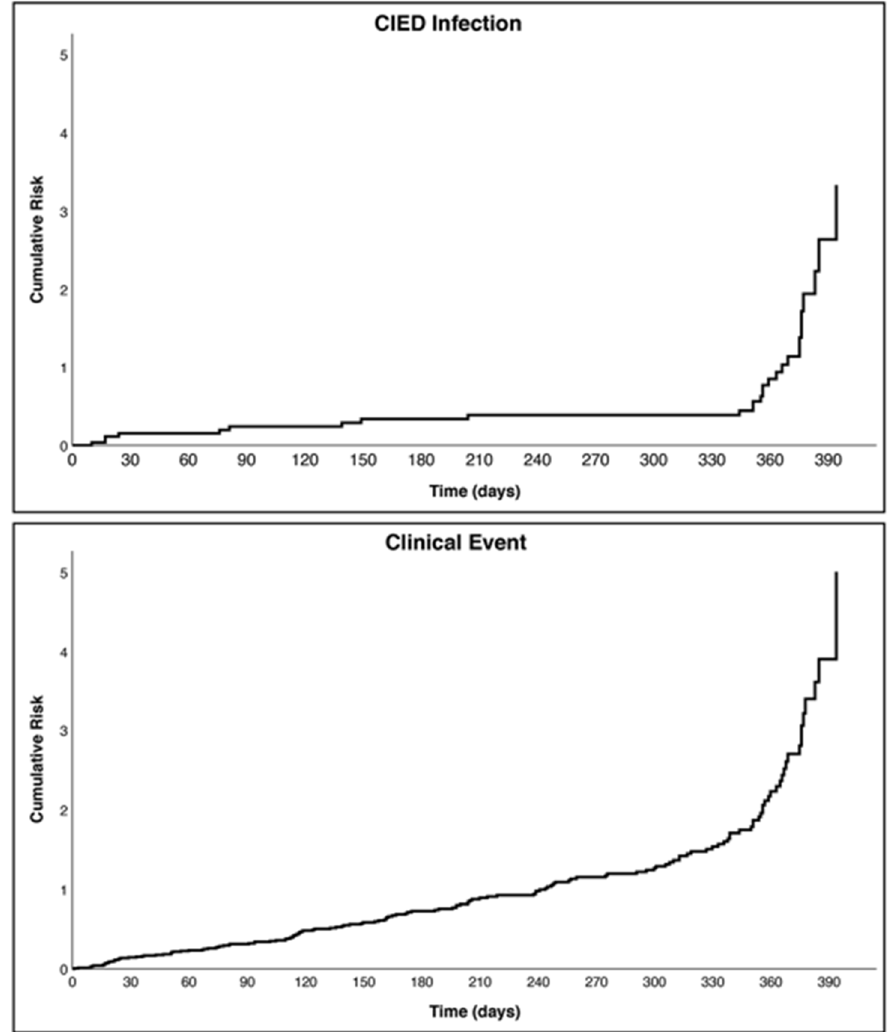
Figure 2. Kaplan–Meier curves for clinical outcomes occurrence. (Upper Figure) and (Cumulative risk for CIED infection; Lower Figure) Cumulative risk for composite clinical event; Legend: CIED= Cardiac Implantable Electronic Device.